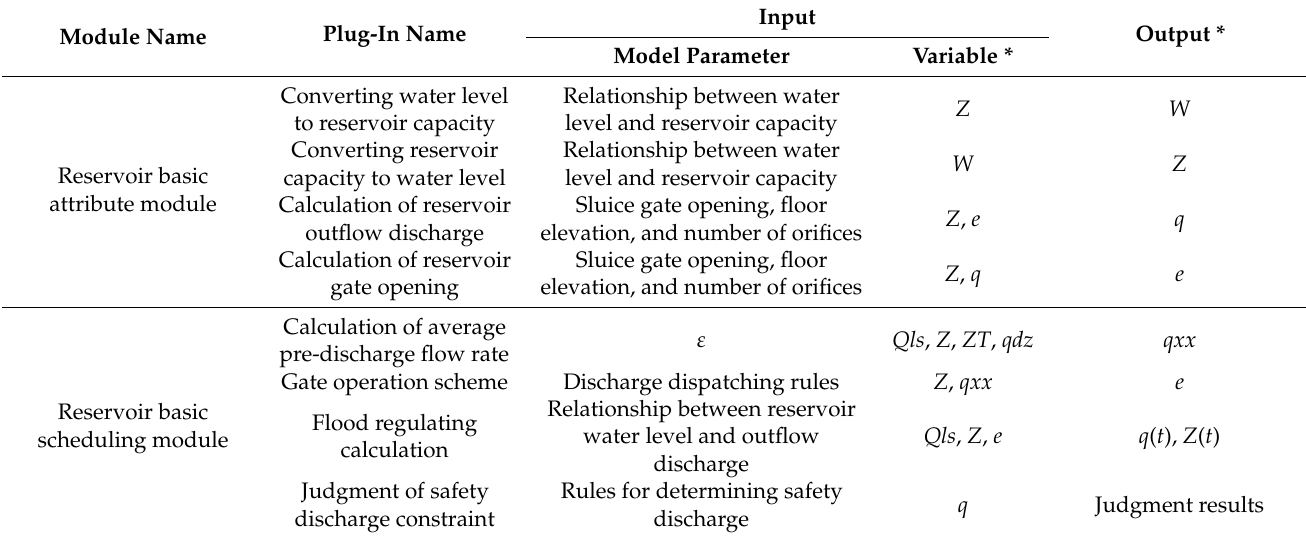
Table 2. Plug-in partition of reservoir flood control scheduling model.